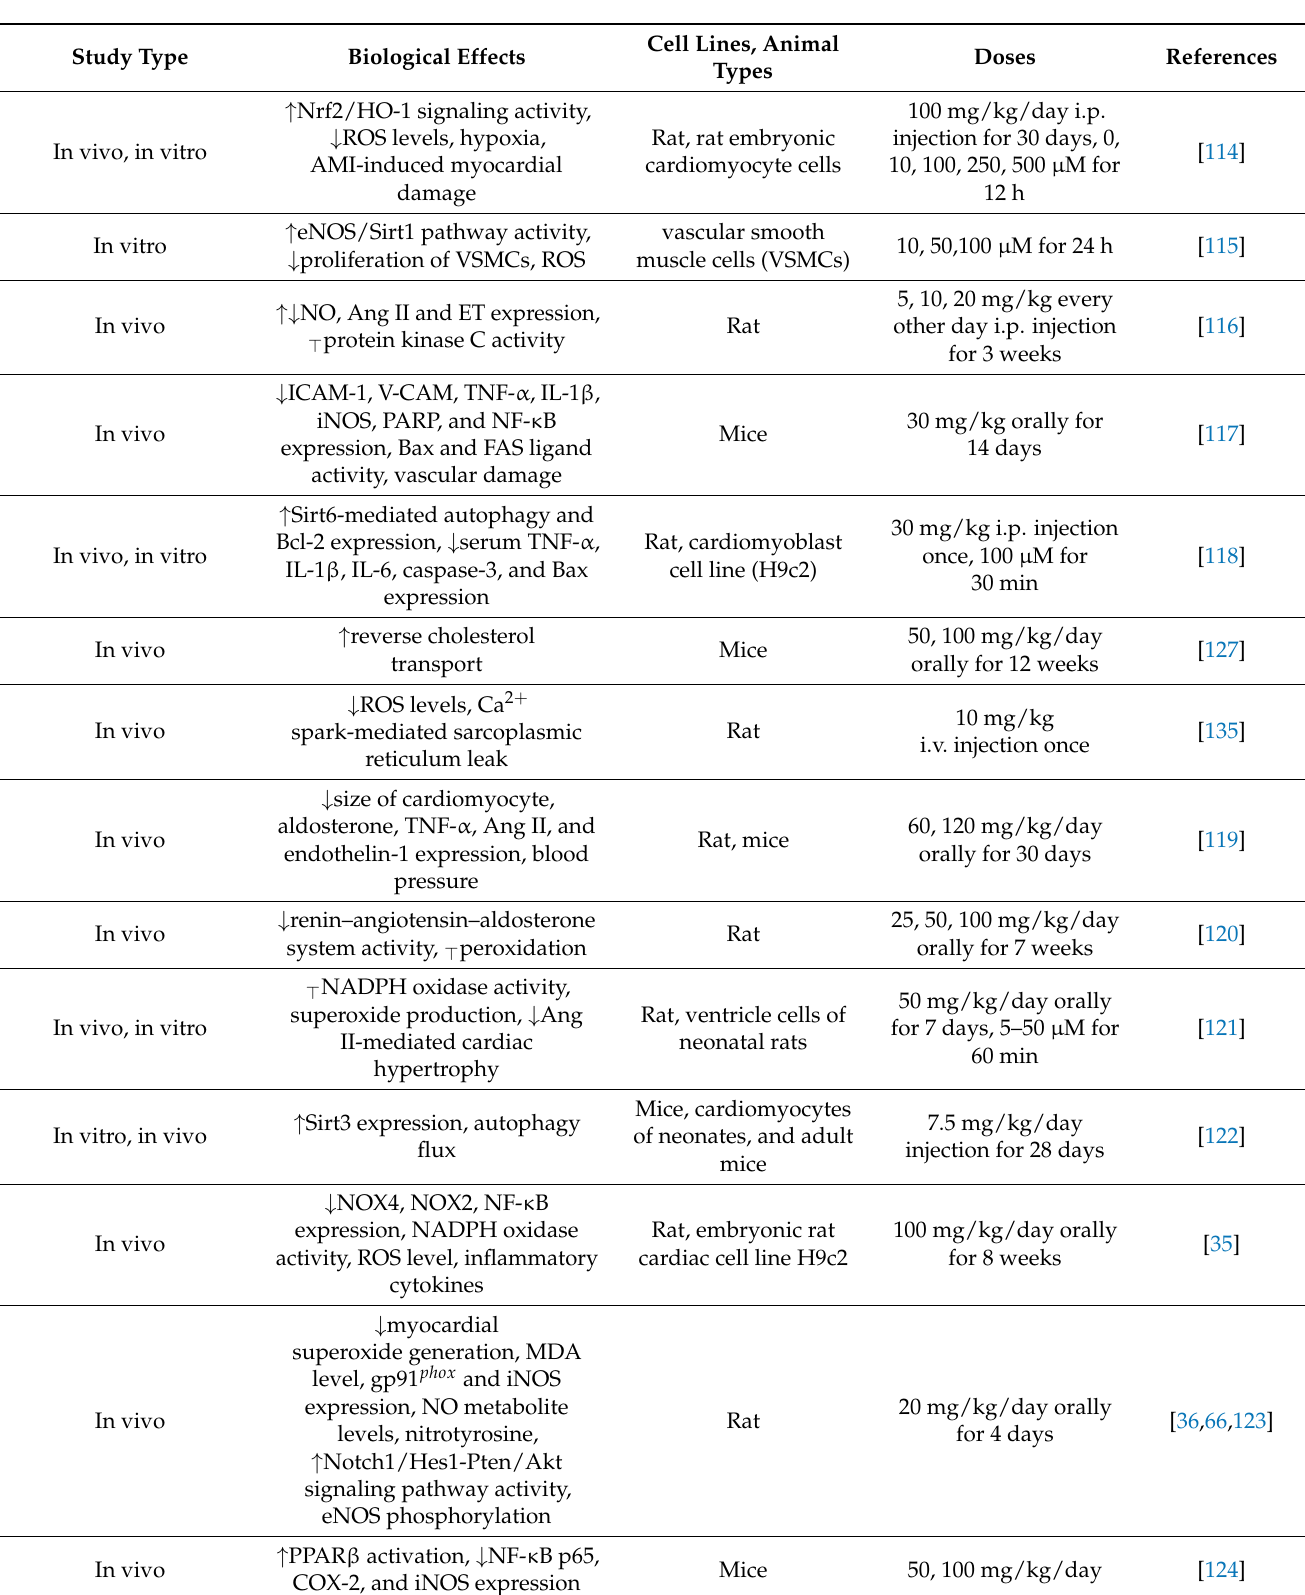
Table 2. Effects of polydatin on cardiovascular